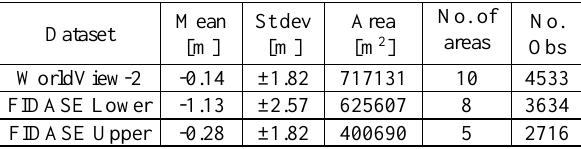
Table 2. Accuracy assessment of Socet GXP DEMs over glacier